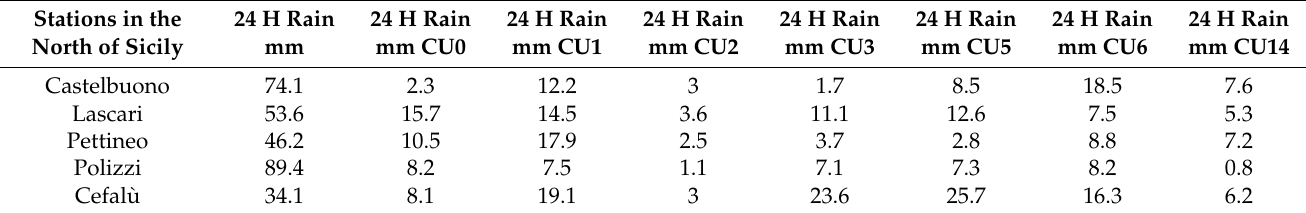
Table 1. The forecasted rainfall data and observed data provided by the 5 stations in the north of Sicily. Stations in the